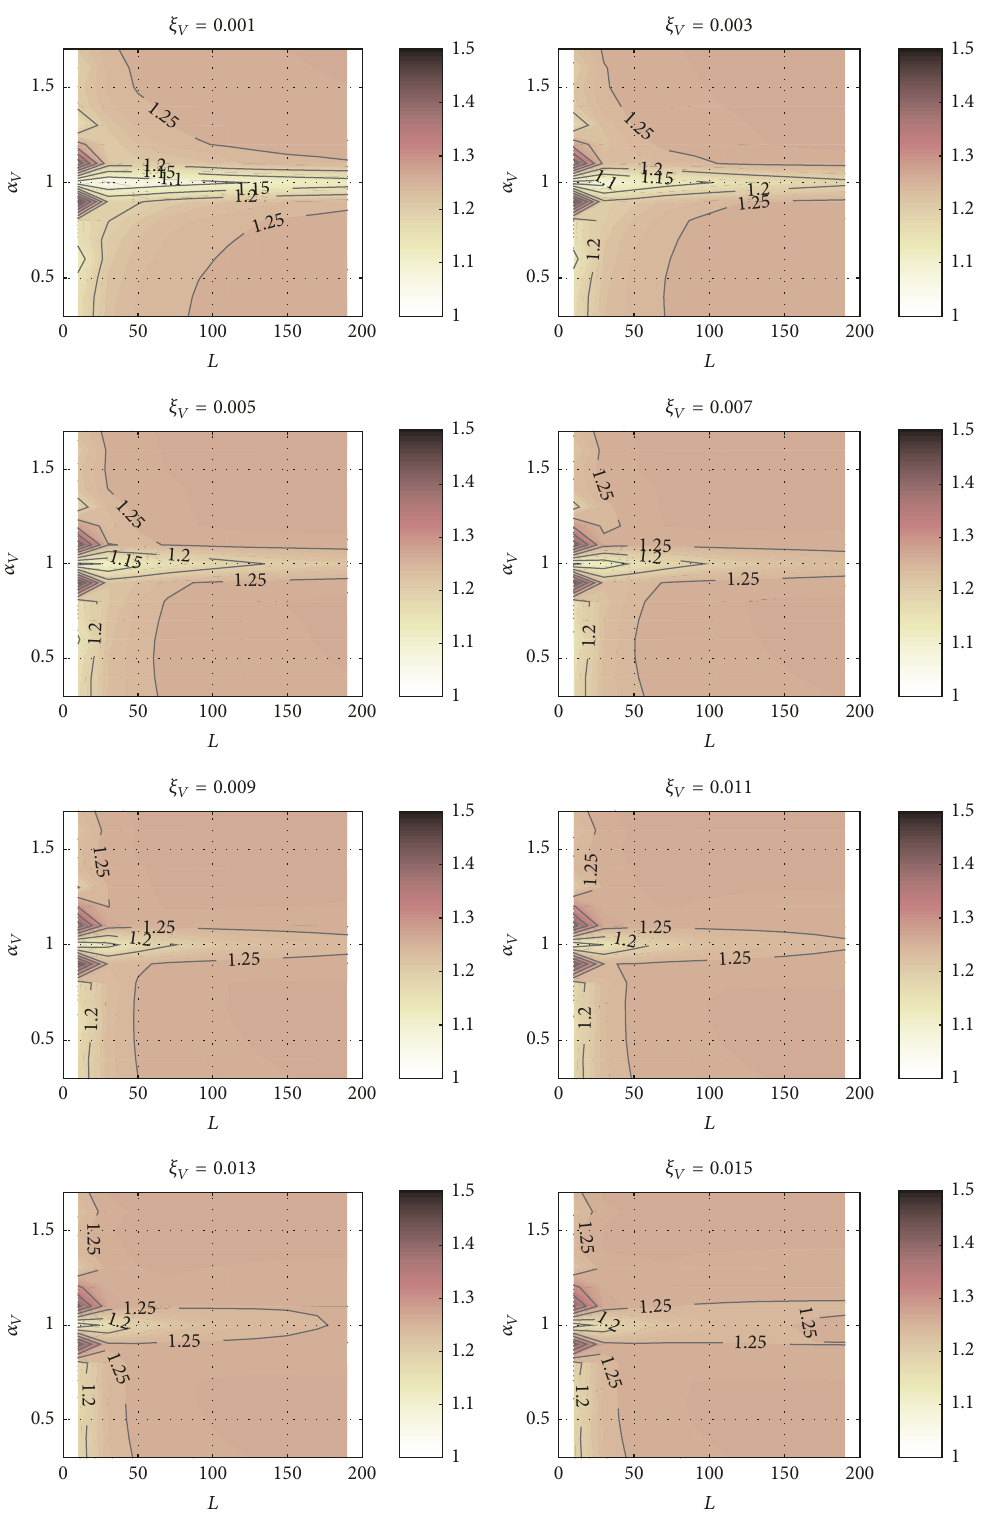
Figure 7: BF 𝑉 ( RL 𝑉 = 1, 𝛼 𝑉 ,𝐿,𝜉 𝑉 ) for different values of 𝜉 𝑉 numerically evaluated using the solution of Abu-Hilal and Mohsen